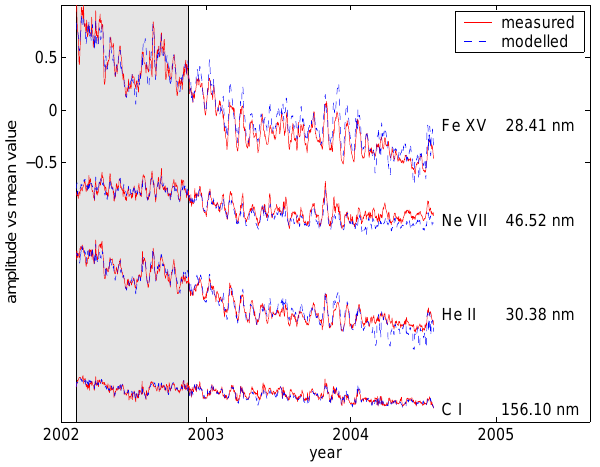
Fig. 11. Comparison between the measured (blue and dashed) and the fitted (red) flux, for 4 typical spectral lines. The fit is based on the 6 lines that minimise the absolute error. The model param- eters are estimated from the first 9 months (area shown in grey); the quality of the fit should therefore not be considered inside this interval. Note that the Fe XV channel shows degradations starting early 2004; these are not taken into account in the computation of the error criterion.